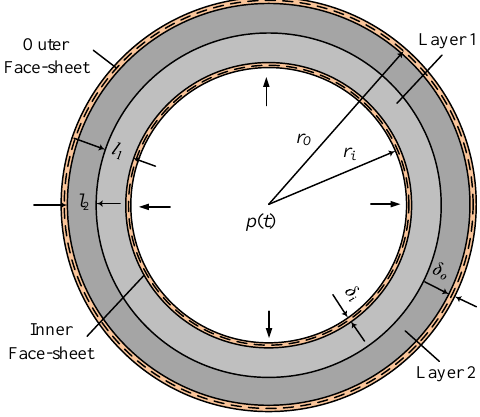
Figure 1. Schematic of the cross-section of a sandwich cylinder/ring.